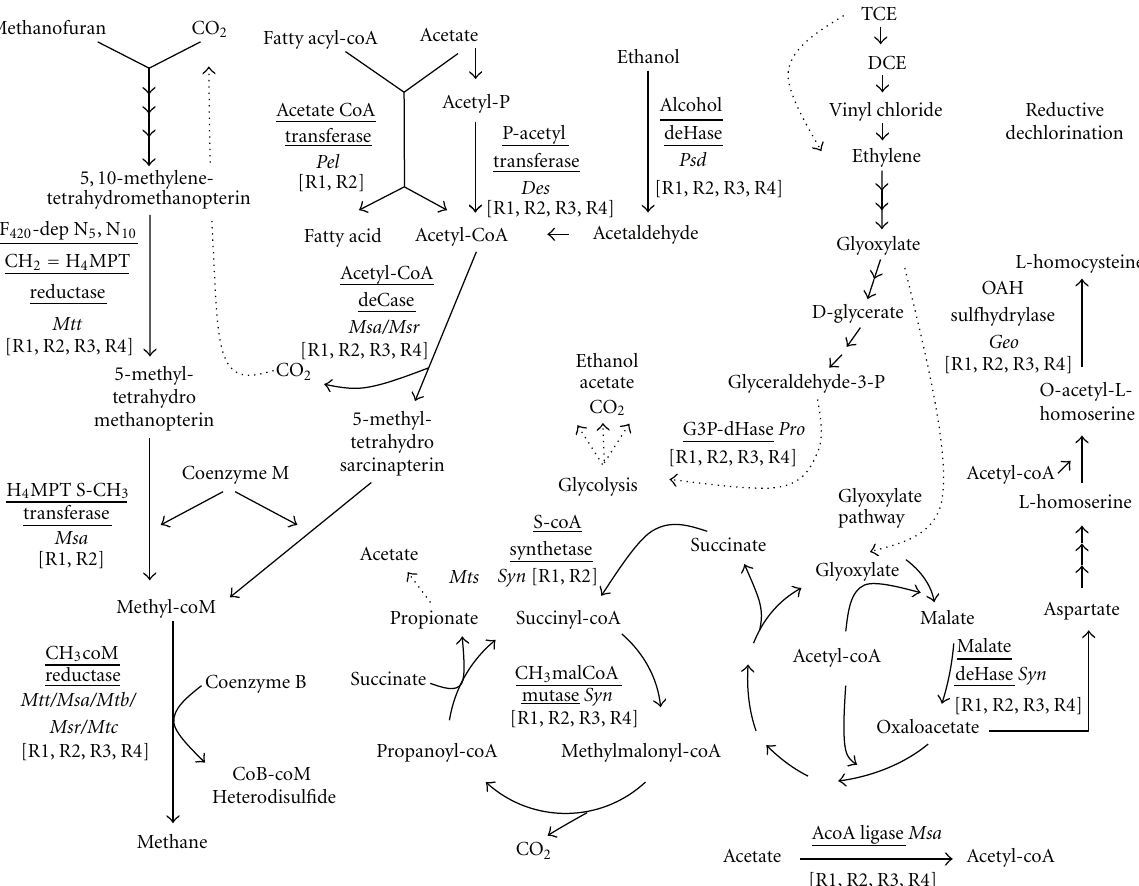
Figure 5: Proposed metabolic pathway for the degradation of VFA and TCE inferred from the metaproteomic data. Enzymes identified in this study are underlined. Species abbreviations are as follows: Mtt Methanothermobacter sp.; Msa Methanosaeta sp.; Mtb